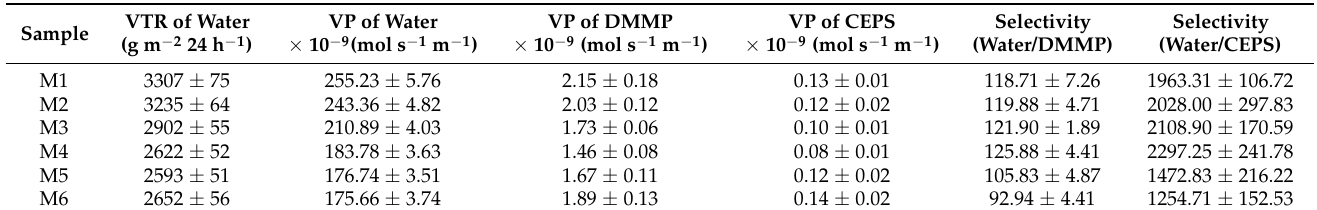
Table 3. VTR of water; VP of water, DMMP, and CEPS; selectivity between water and DMMP; and selectivity between water and CEPS of M1–M6 membranes.